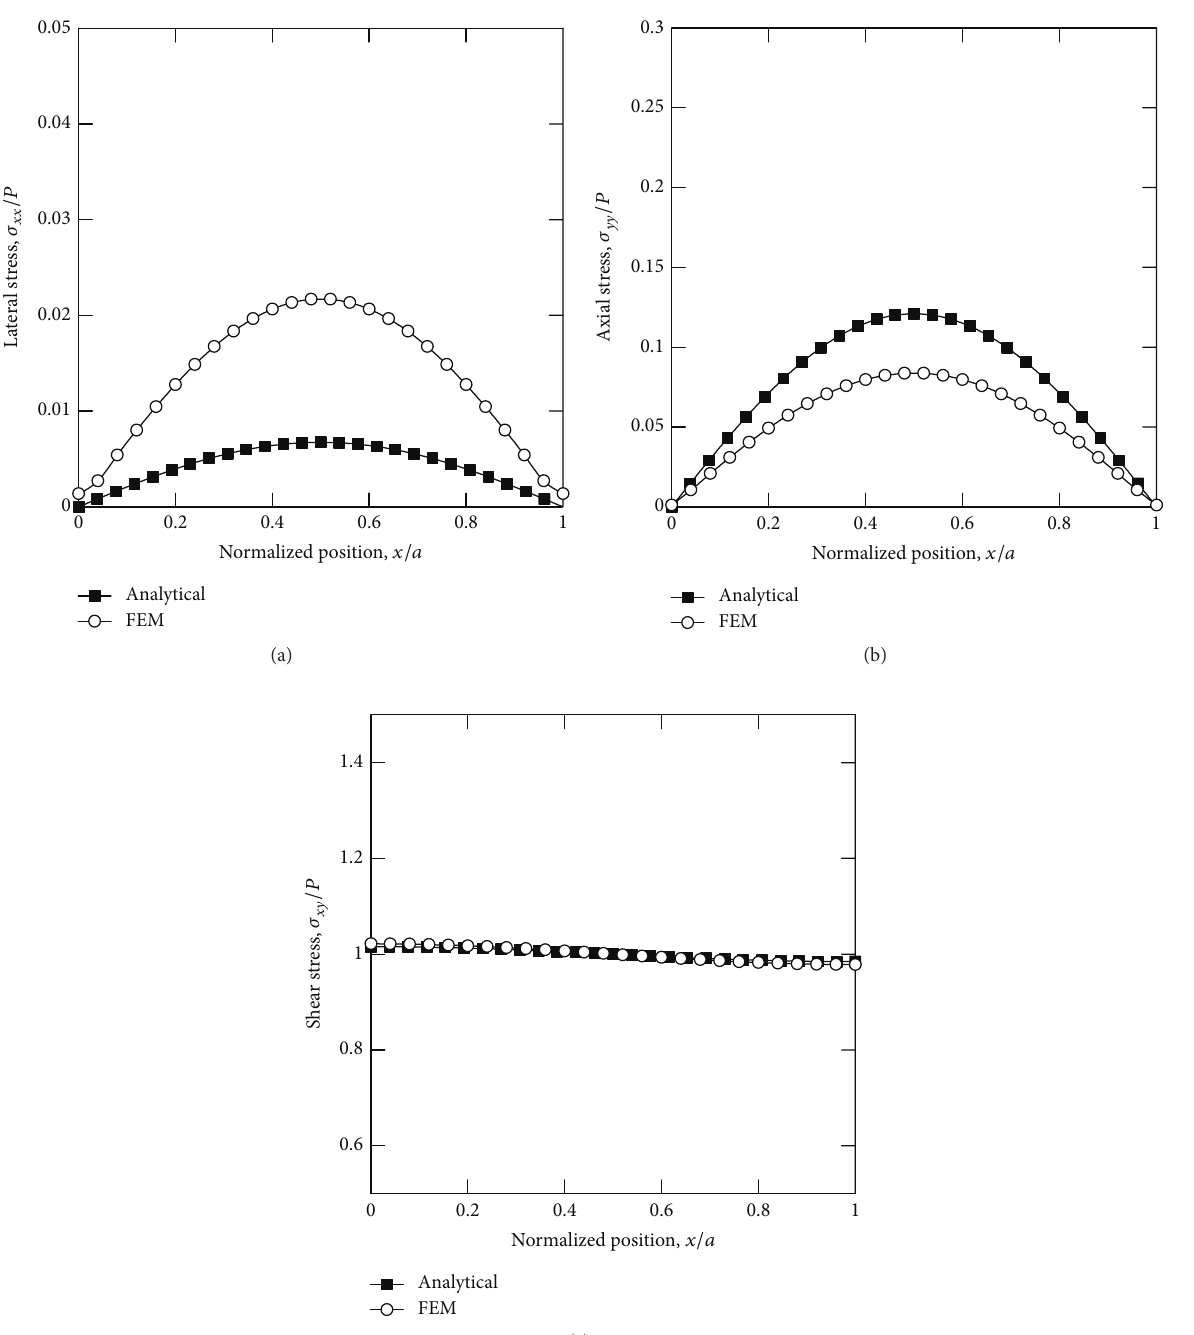
Figure 10: Comparison of solutions of different stress components at the section 𝑦/𝑏 = 0 by analytical and FE methods: (a) lateral stress; (b) axia stress and (c) shear